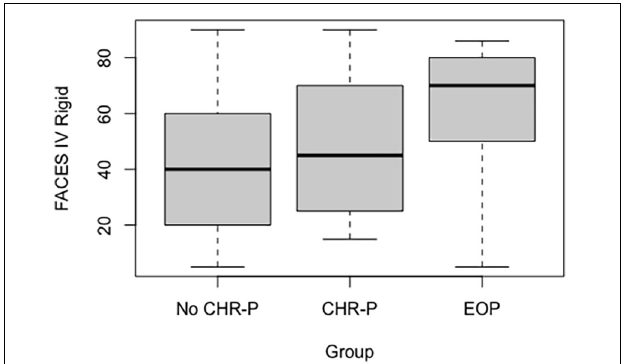
FIGURE 2 | Mothers’ rigidity subscale in the three